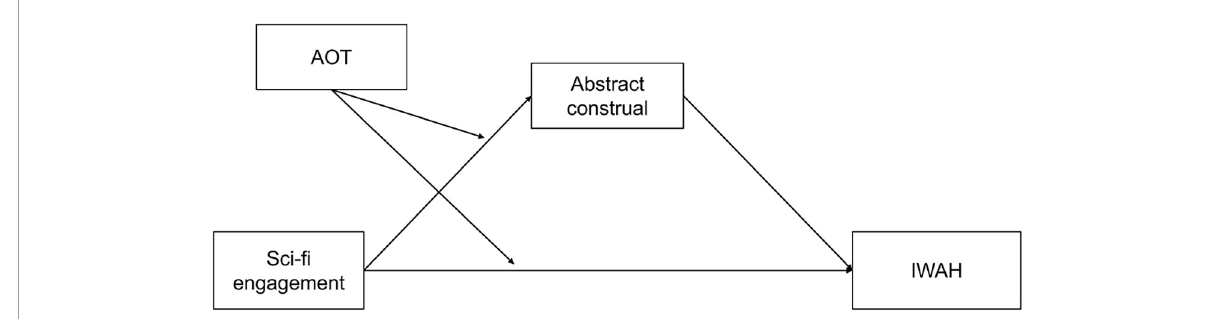
FIGURE1 The proposed research model. IWAH, Identification with all humanity; AOT, Actively open-minded thinking.